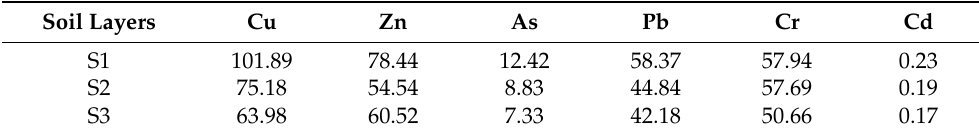
Table 3. Background values of soil heavy metals in the study area (mg/kg).